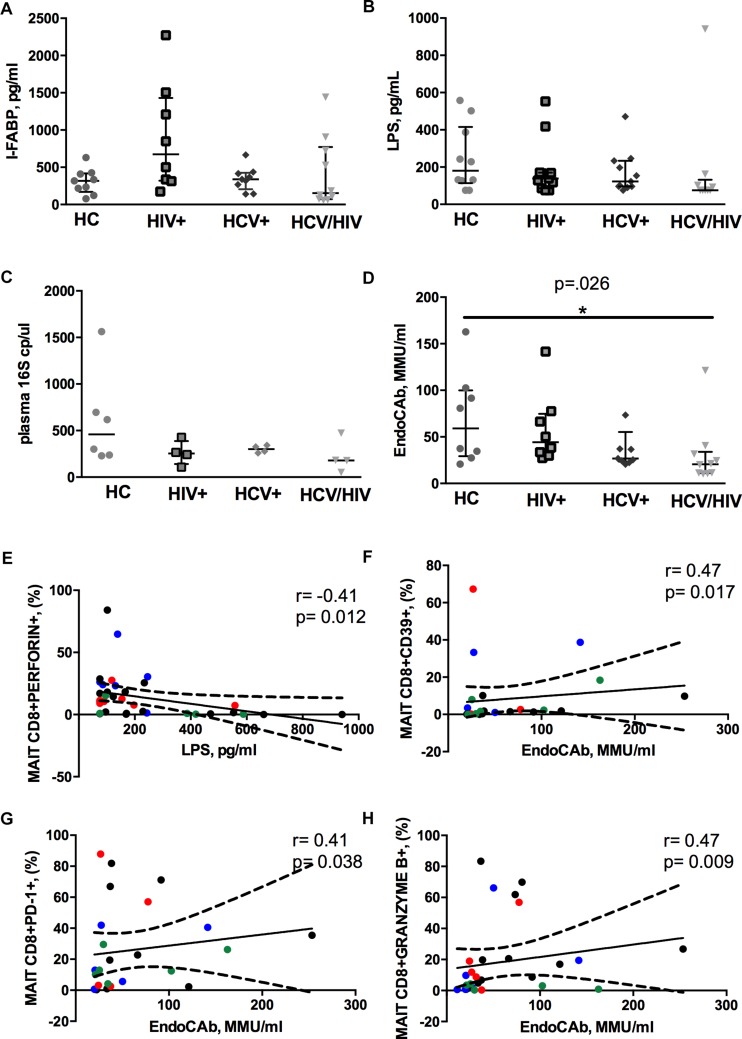
Circulating microbial translocation and gut damage markers and their associations with Vα7.2+CD161++CD8+. The lines indicate the significant comparison between two groups. ∗ indicates the p-value for each pair of groups: ∗
p < 0.05, ∗∗
p < 0.01, ∗∗∗
p < 0.001. (A) The levels of I-FABP, marker of enterocyte damage, were similar between the donor group and the infected patients (HC: 317 pg/ml [169–418], HIV+: 675 pg/ml [319–1431], HCV+: 339 pg/ml [206–426], HCV/HIV: 154 pg/ml [72–771], p = 0.158). (B) We observed similar plasma levels of LPS (HC: 180 pg/ml [114–416], HIV+: 138 pg/ml [86–170], HCV+ 123 pg/ml [96–234], HCV/HIV: 75 pg/ml [75–132], p = 0.188) between the study groups. (C) Circulating 16S rDNA in a subgroup of 5 patients per group was comparable (HC: 458 cp/ml [235–913], HIV+: 253 cp/ml [141–387], HCV+: 301 cp/ml [264–338], HCV/HIV: 179 cp/ml [83–400], p = 0.261). (D) The plasma levels of endotoxin core antibodies (EndoCAb) were significantly lower in virally infected subjects, particularly HCV/HIV co-infected patients (HC: 59 MMU/ml [29–100], HIV+ 44 MMU/ml [31–75], HCV+: 27 MMU/ml [23–55], HCV/HIV: 21 MMU/ml [11–34] p = 0.026). (E–H) Each patients’ cohort is marked by a different color: HC are represented in green, HIV+ in red, HCV+ in blue, HCV/HIV co-infected patients in black. (E) LPS plasma levels negatively correlate with perforin-expressing MAITs (r = –0.41, p = 0.012). (F) EndoCAb levels were positively associated with exhausted MAITs (CD39 +): r = 0.47, p = 0.017. (G) Vα7.2+CD161++CD8+PD1+ T-cells were positively associated with EndoCAb levels (r = 0.41, p = 0.38). (H) Granzyme B-expressing MAITs positively associate with plasma EndoCAb (r = 0.47, p = 0.09).